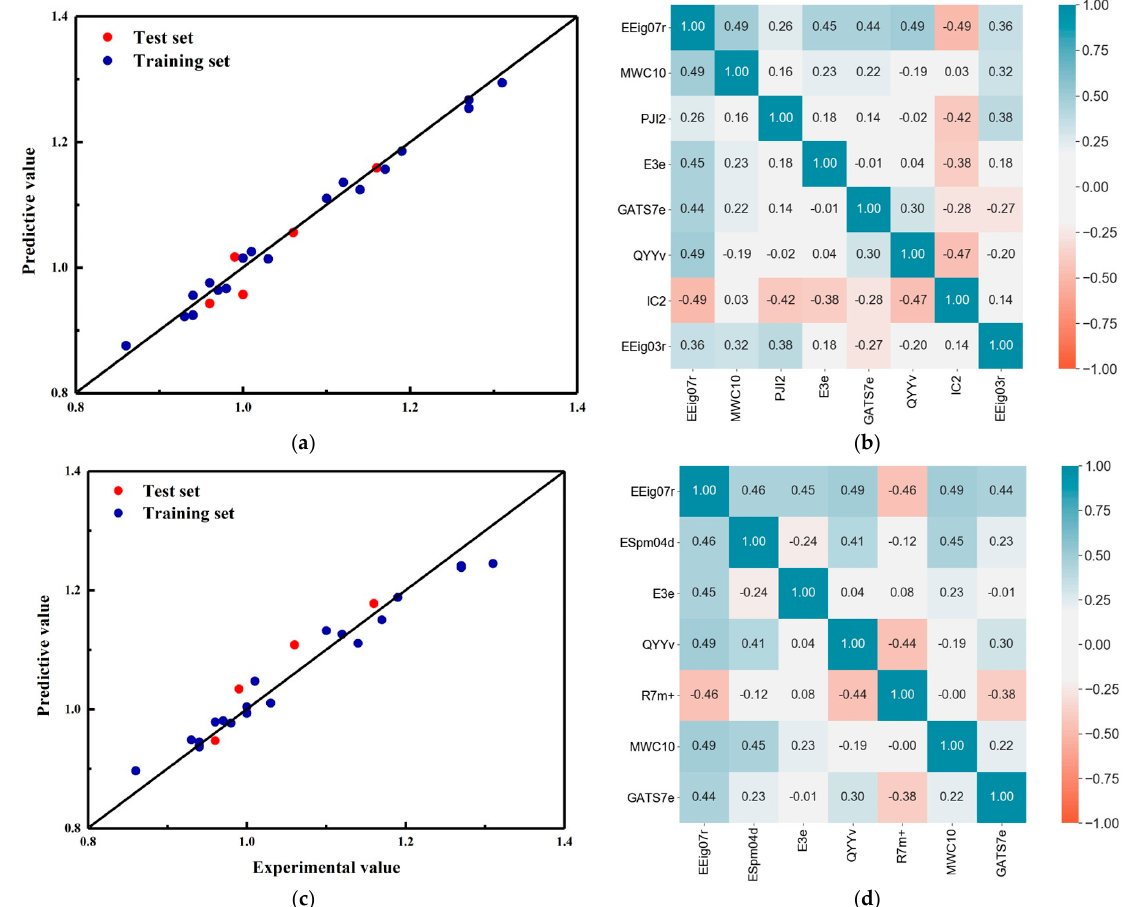
Figure 3. The prediction results of different regression models based on grid optimization and the correlation of descriptors. ( a ) And ( b ) SVM; ( c ) and ( d )